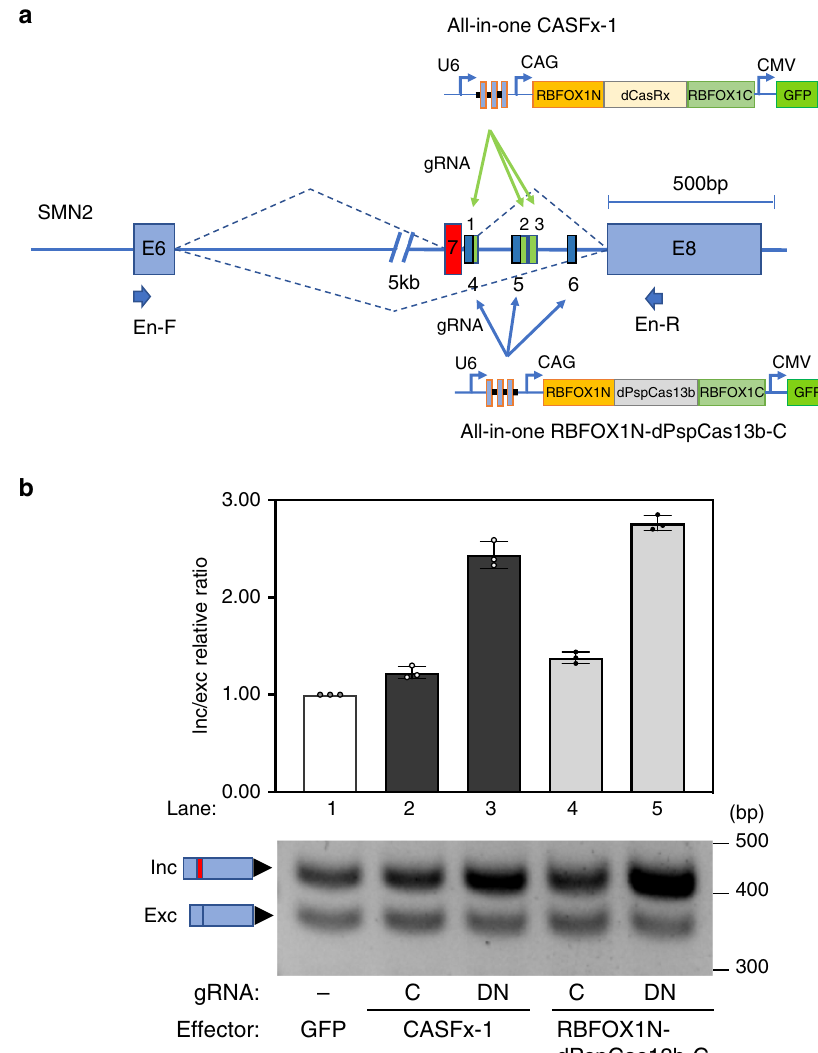
Fig. 6 Exon activation in SMA patient cells by CASFx. a Schematic of the two all-in-one CASFx constructs (CASFx-1: RBFOX1N-dCasRx-C and RBFOX1N- dPspCas13b-C) and six gRNAs targeting the corresponding numbered locations on the endogenous intron. b Upper panel shows inclusion/exclusion ratio fold-changes of the endogenous SMN2 gene in patient cells assayed by qRT-PCR 5 days after nucleofection with the indicated CASFx and gRNA relative to GFP control (set to 1). Data are represented as mean ± SD ( n = 3). Lower panel shows a gel image of semi-quantitative splicing RT-PCR using primers En-F and En-R on endogenous SMN2 transcripts in the indicated samples. Uncropped gel images and qRT-PCR values are included in the Source Data fi